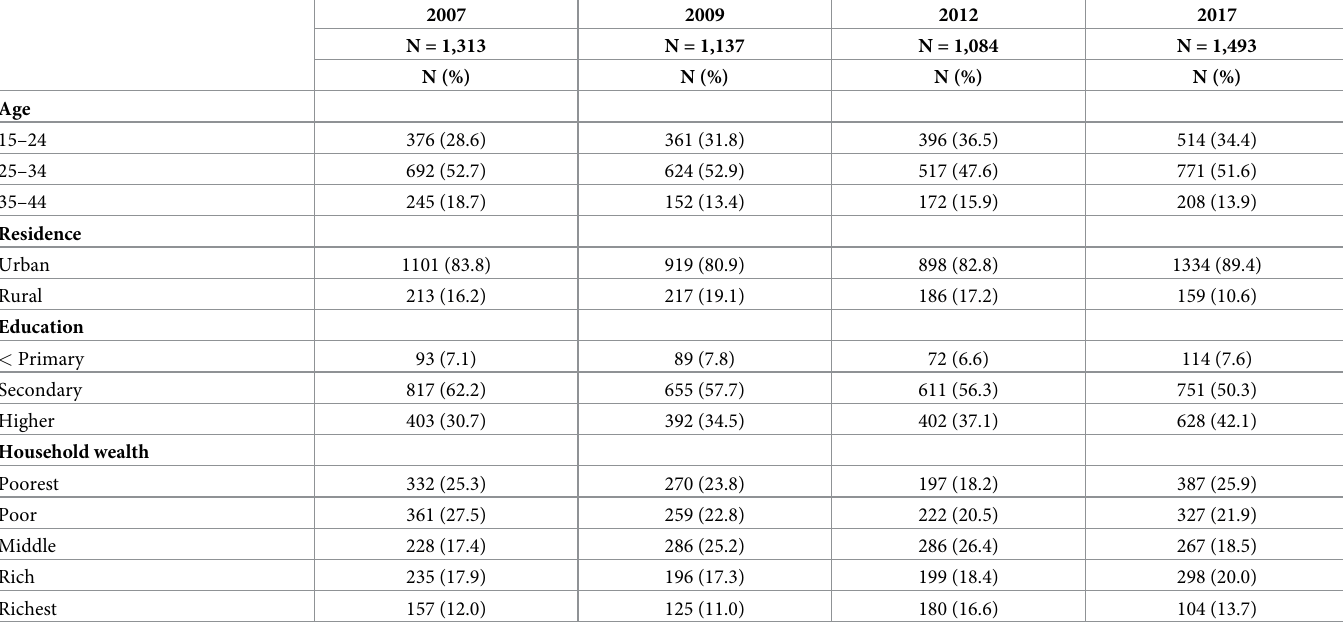
Table 2. Socio-demographics of pregnant women across the four waves of DHS data.